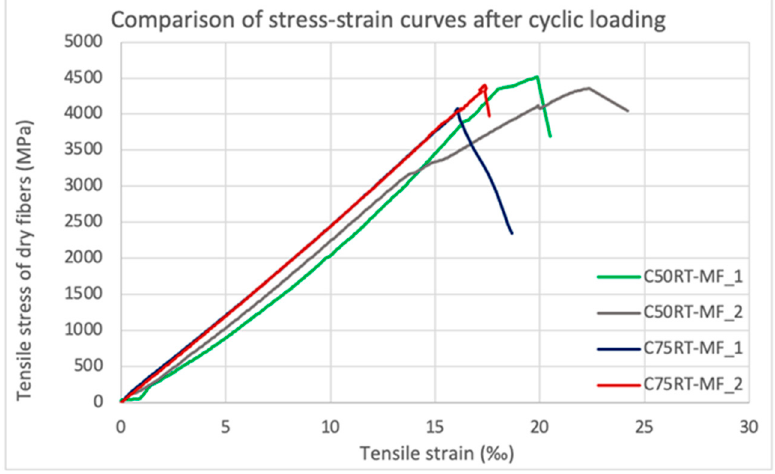
Figure 10. Stress–strain curves of monotonic, uniaxial tension at room temperature after low-cycle fatigue.